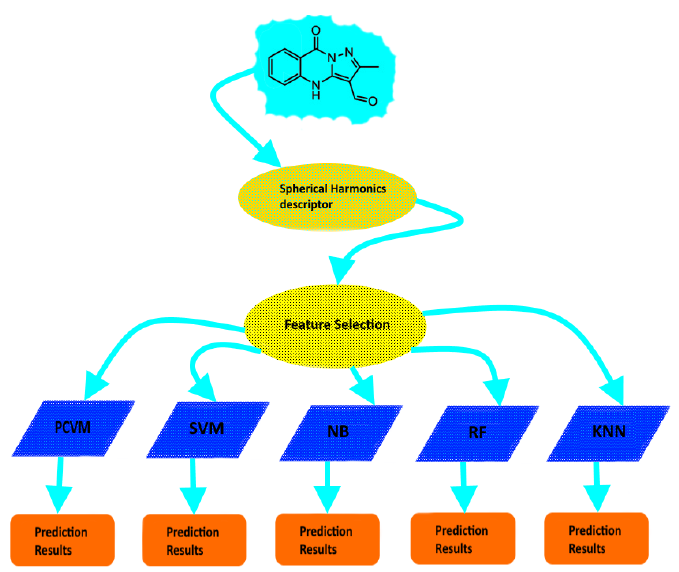
Figure 1. Flowchart of research methodology.